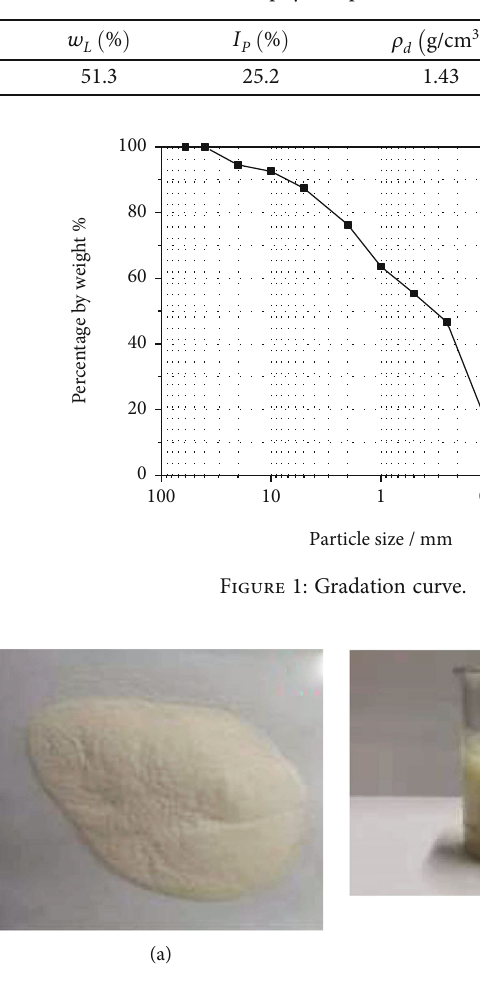
Figure 2: Physical morphology of xanthan gum.